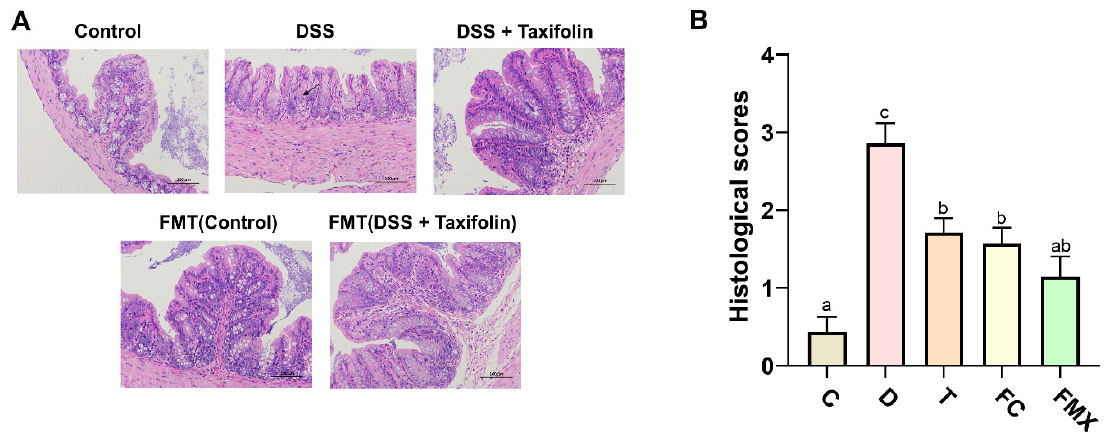
Figure 2. Taxifolin and FMT alleviated DSS-induced intestinal mucositis in mice. H&E staining of colon sections (200 ×). ( A ) Control mice showing normal mucosa; DSS group, showing mucosa atrophy and villi loss with the degeneration and necrosis of epithelium cells and infiltration of inflammatory cells; DSS + Taxifolin group mice, showing mucosa had better morphological structure and infiltrated with less inflammatory cells; FC(FMT Control) mice, showing mucosa had better morphological structure; FT(FMT DSS + Taxifolin) mice, showing mucosa had better morphological structure. ( B ) The histological scores of the five group. The letters abc are significant markers, and any difference with one of the same marker letters is not significant, and any difference with different marker letters is significant.